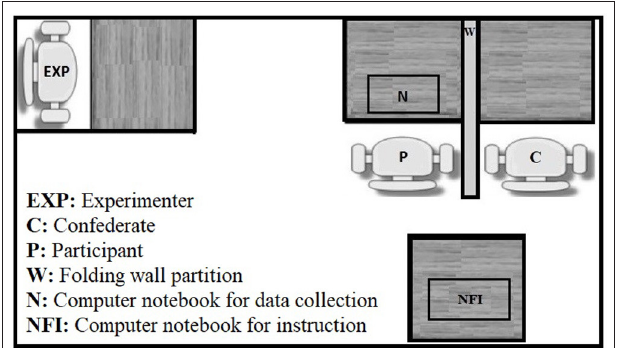
FIGURE 1 | An overhead depiction of the experimental setting, including the table and chairs disposition in the experimental room, as well as the position where the confederate, the participant and the experimenter remained throughout the